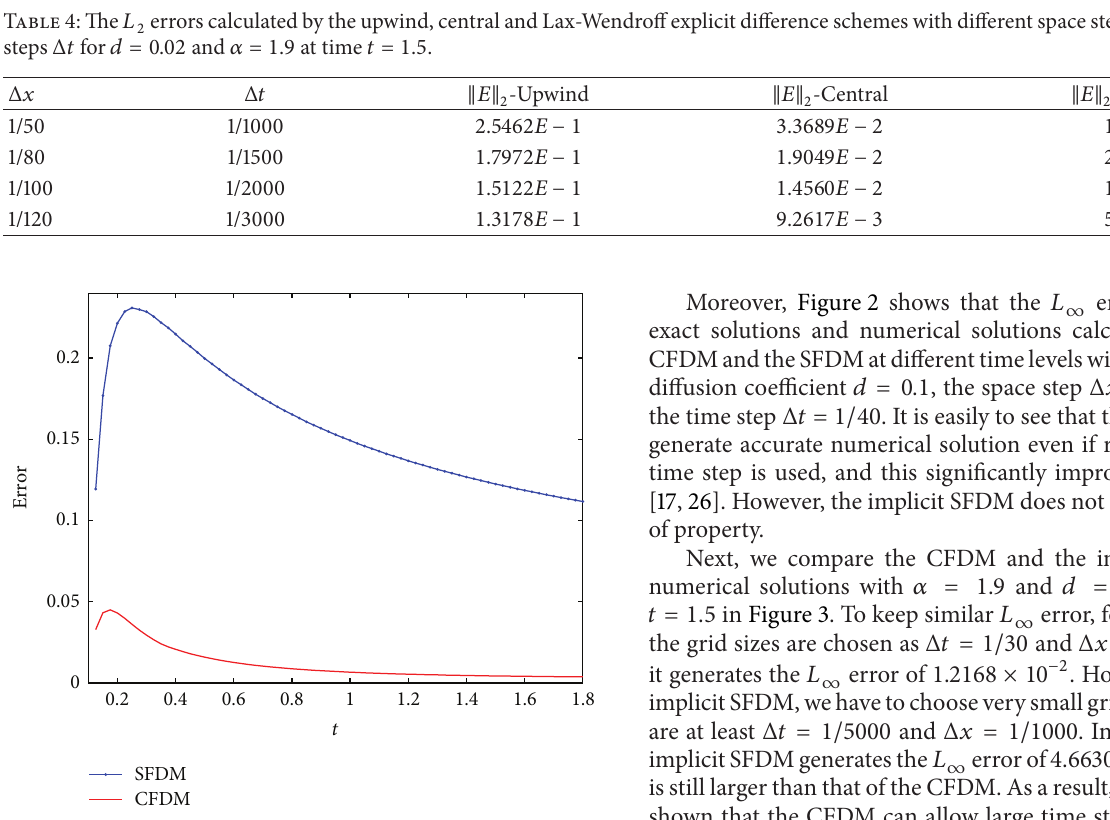
Figure 2: The 𝐿 ∞ errors between exact solutions and numerical solutions calculated by the CFDM (12) and the implicit SFDM at different time levels with 𝛼 = 1.9 , Δ𝑥 = 1/50 , and Δ𝑡 = 1/40 for 𝑑 = 0.1